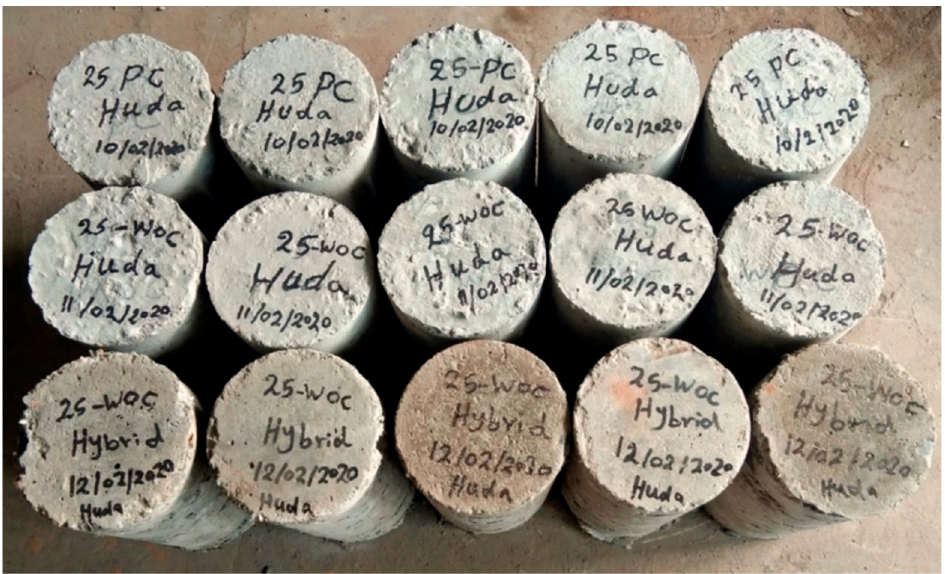
Figure 5. The used concrete specimens.